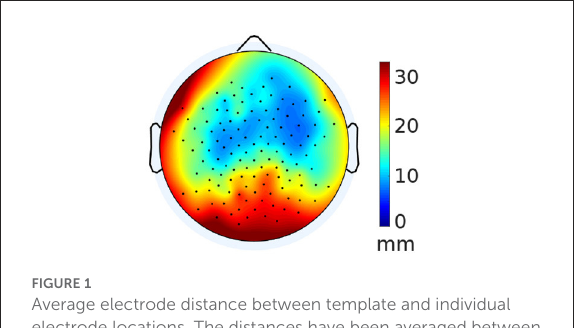
FIGURE1 Average electrode distance between template and individual electrode locations. The distances have been averaged between anatomies, as the values show minimal deviation from each